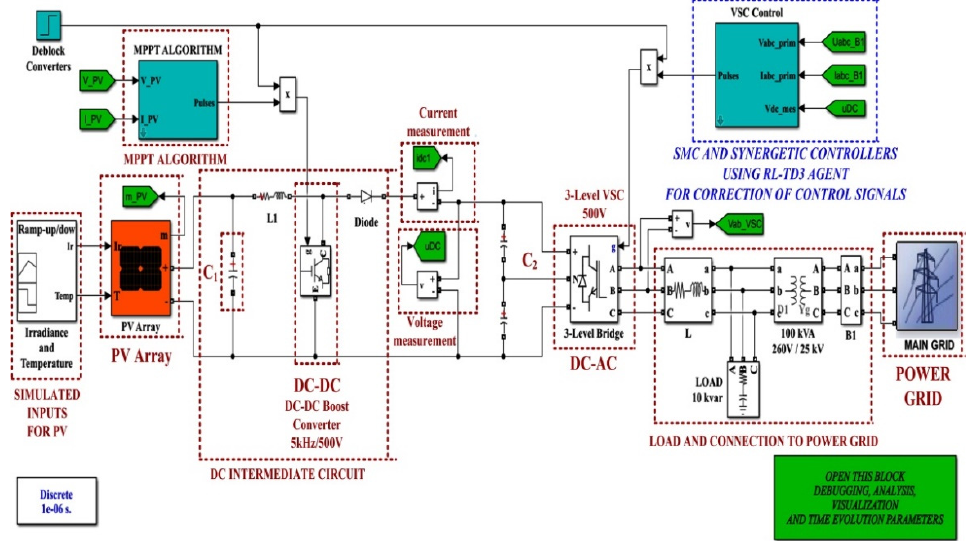
18 of 33 Figure 19. The MATLAB Simulink implementation subsystem for the SYN controller.